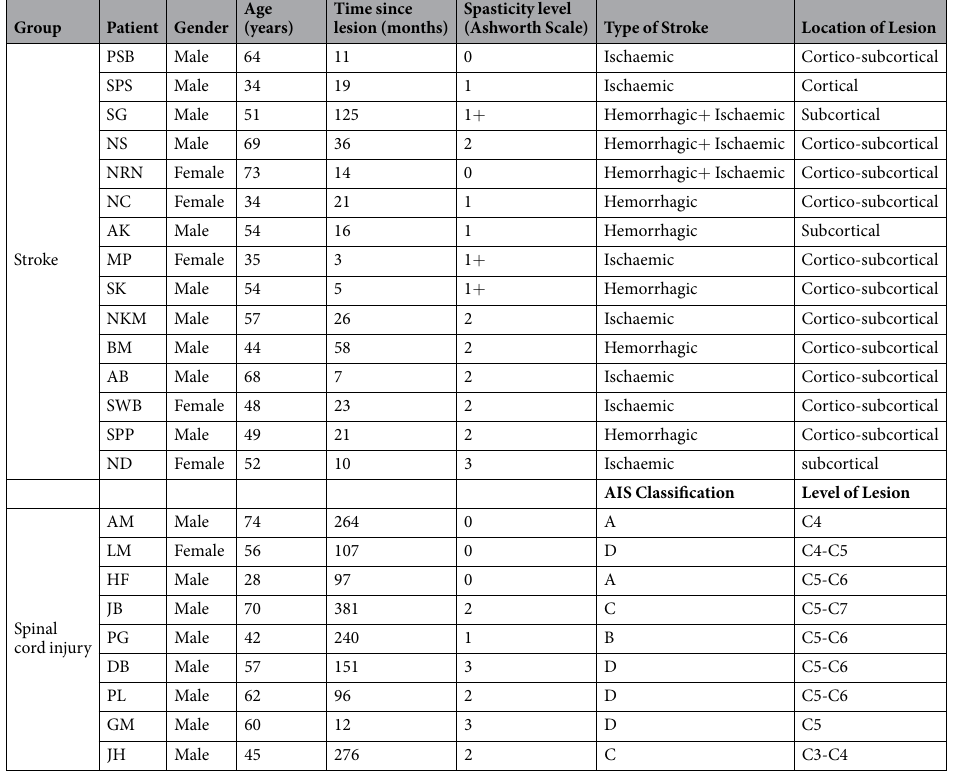
Table 1. General information about patients with stroke and spinal cord injury and their